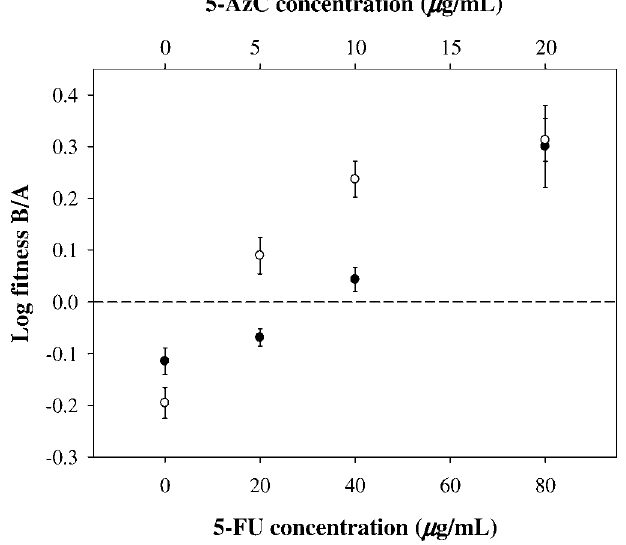
Figure 3. Competition Experiments at Varying 5-FU and 5-AzC Doses Open circles and filled circles represent 5-FU and 5-AzC values, respectively. The log-fitness of population B relative to population A, log( W B / W A ), is represented. Bars indicate 95% confidence intervals.